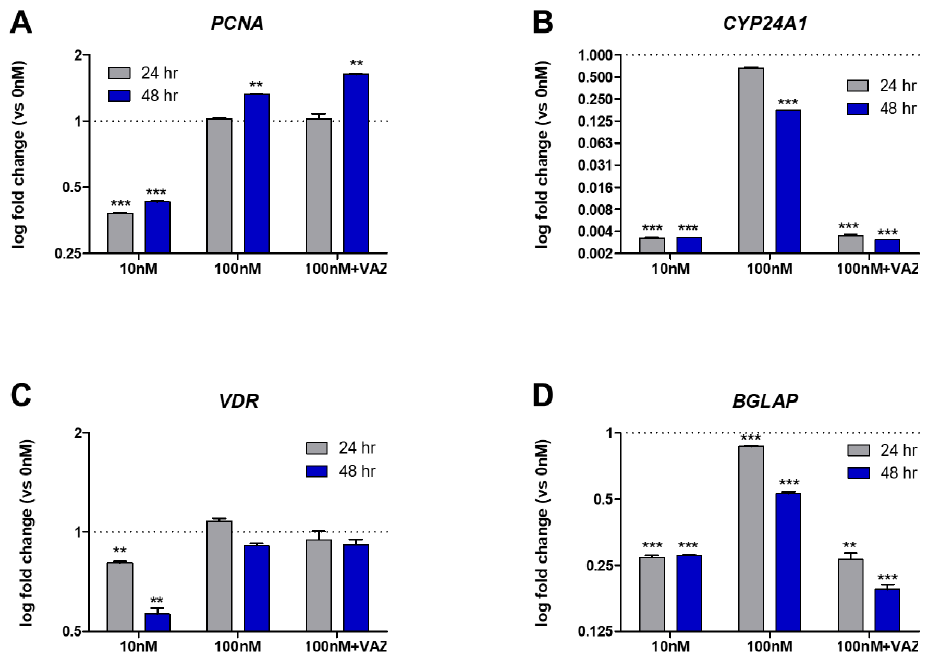
Figure 2. ( A ) Dose-dependent suppression of proliferating cell nuclear antigen (PCNA) transcript levels by vitamin D. Real-time PCR analysis of PCNA (proliferating cell nuclear antigen) transcript levels in MG-63 cells in complete media. ( B ) Dose- and time-dependent suppression of cytochrome P450 family 24 subfamily A member 1 (CYP24A1) transcript levels by vitamin D. Real-time PCR analysis of CYP24A1 (cytochrome P450 family 24 subfamily A member 1) transcript levels in MG-63 cells in complete media. ( C ) Dose- and time-dependent suppression of vitamin D receptor (VDR) transcript levels by vitamin D. Real-time PCR analysis of VDR (vitamin D receptor) transcript levels in MG-63 cells in complete media. ( D ) Dose- and time-dependent suppression of bone Gamma- Carboxyglutamate Protein, or osteocalcin (BGLAP) transcript levels by vitamin D. Real-time PCR analysis of BGLAP (bone Gamma-Carboxyglutamate Protein, or osteocalcin) transcript levels in MG- 63 cells in complete media. p ≤ 0.05*, 0.01**, 0.001*** using the 2-way ANOVA with Bonferroni post hoc test ( n = 3; error bars represent the SD). VAZ (vitamin D receptor antagonist ZK159222). 2.3. Vitamin D Treatment Does Not Inhibit the Transcription of Respiratory Chain Genes Cytochrome C Oxidase Subunit 2 (COXII) and Subunit 4 Isoform 1 (COX4I1) in MG-63 Cells Recent studies have shown that vitamin D can suppress the production of cellular ROS in MG- 63 cells [[39]], however the mode of action is unknown. First mitochondrial and nuclear transcription of cytochrome c oxidase subunit 2 (COXII) and subunit 4 isoform 1 (COX4I1) mRNA, respectively, were characterized after 1,25D 3 treatment over time as potential players in ROS regulation. These proteins are subunits of cytochrome c oxidase complex IV part of the active mitochondrial respiratory chain and contribute to the proton electrochemical gradient across the inner mitochondrial membrane. Previous studies have shown that both of these subunits were inhibited after 1,25D 3 treatment in skin keratinocyte models [[50]], and may be involved in osteosarcoma. However, after both 10 nM and 100 nM 1,25D 3 and VAZ co-treatments of MG-63 cells for 24 and 48 h, no striking differences in the gene expression of both COXII and COX4I1 were observed (Figure 3A,B). These results suggest that 1,25D 3 does not modulate active cytochrome c oxidase via COXII and COX4I1 subunits at the transcriptional level. These results point to alternative mitochondrial regulators, including perhaps other components of the electron transport chain, in the regulation of ROS by vitamin D [[39]].